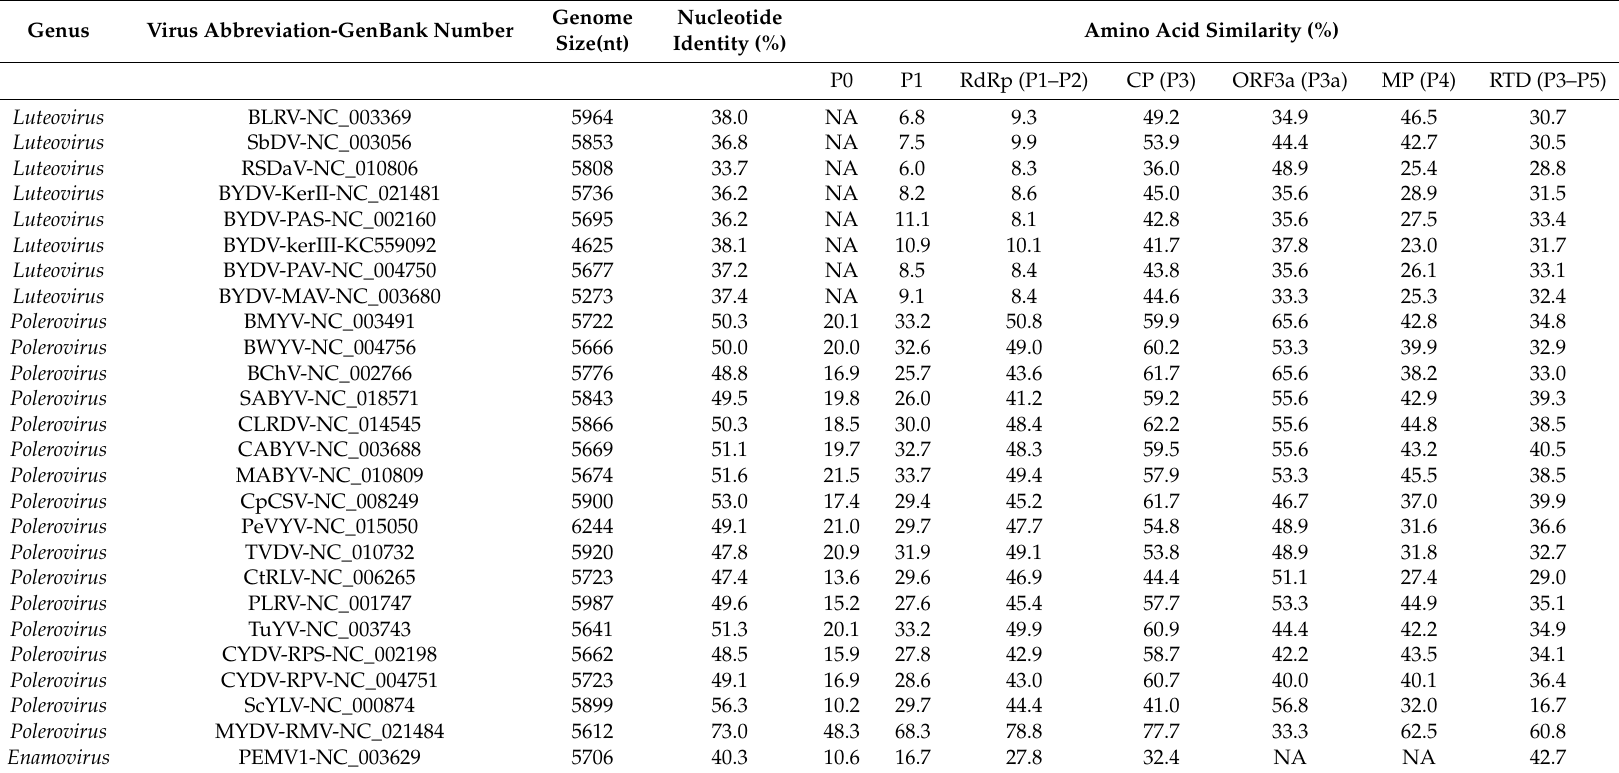
Table 2. Percent nucleotide and amino acid sequence identity between ORFs of MaYMV and other members of the Luteoviridae